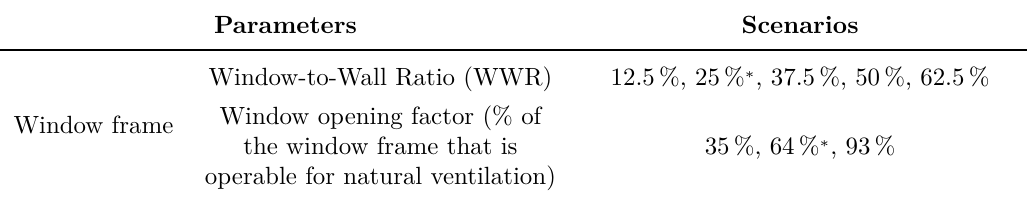
Table 2. Variable